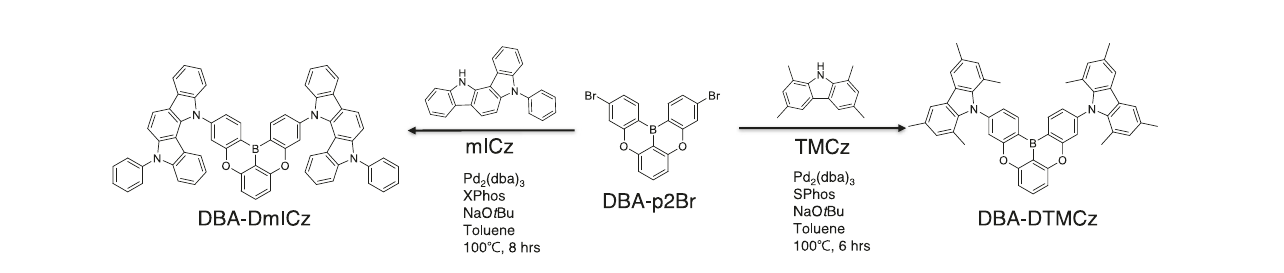
Fig. 2 | Synthetic scheme. Synthetic routes for DBA-DmICz and